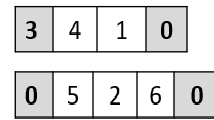
Fig. 3. Chromosome